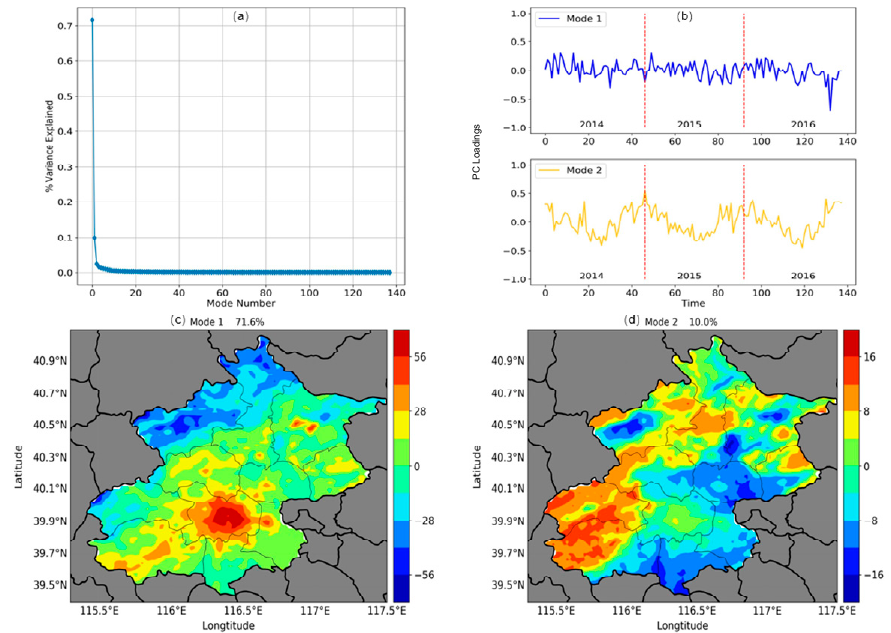
Figure 7. The T-mode PCA results for Beijing surface temperature data during 2014–2016: ( a ) the variance explained by the principal covariance analysis (PCA) modes for surface temperature; ( b ) the PC time series for the first two modes (the red vertical lines are used to divide data into different years); ( c , d ) the spatial patterns of the first two modes for PCA results.